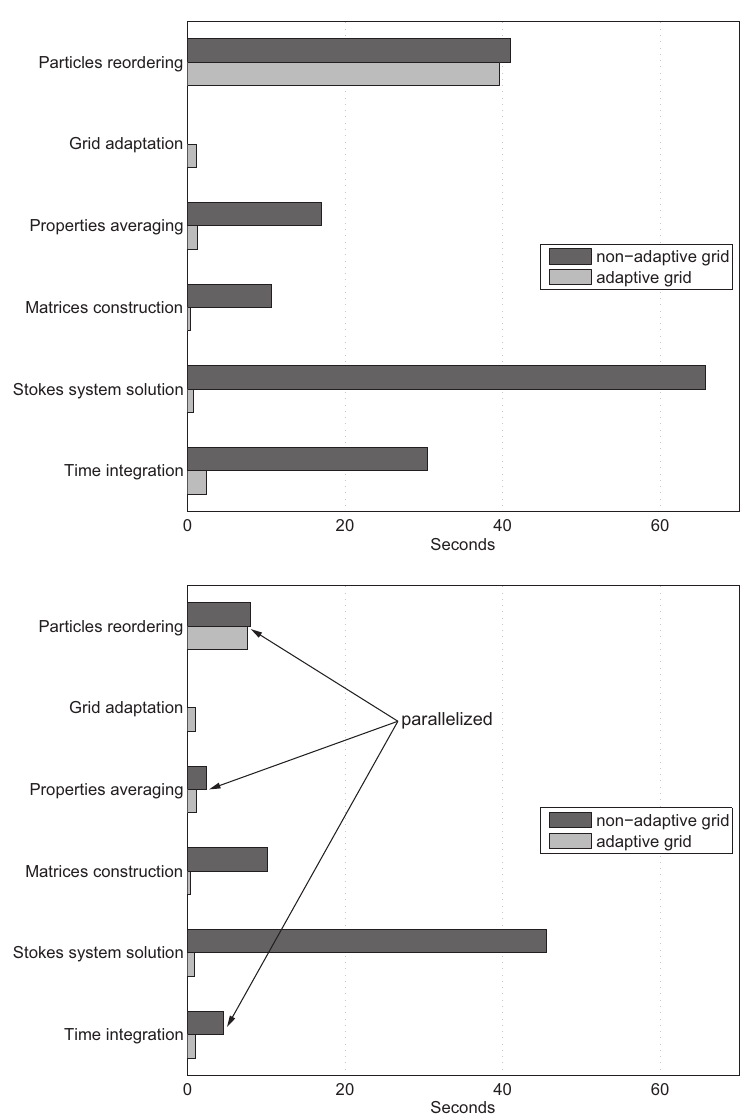
Figure 17. Performance comparisons between adaptive and non-adaptive numerical schemes for sinking block model; top : 1 CPU; bottom : 8 CPUs with MATLAB Parallel Computing Toolbox. Dual AMD Opteron 8380 system was